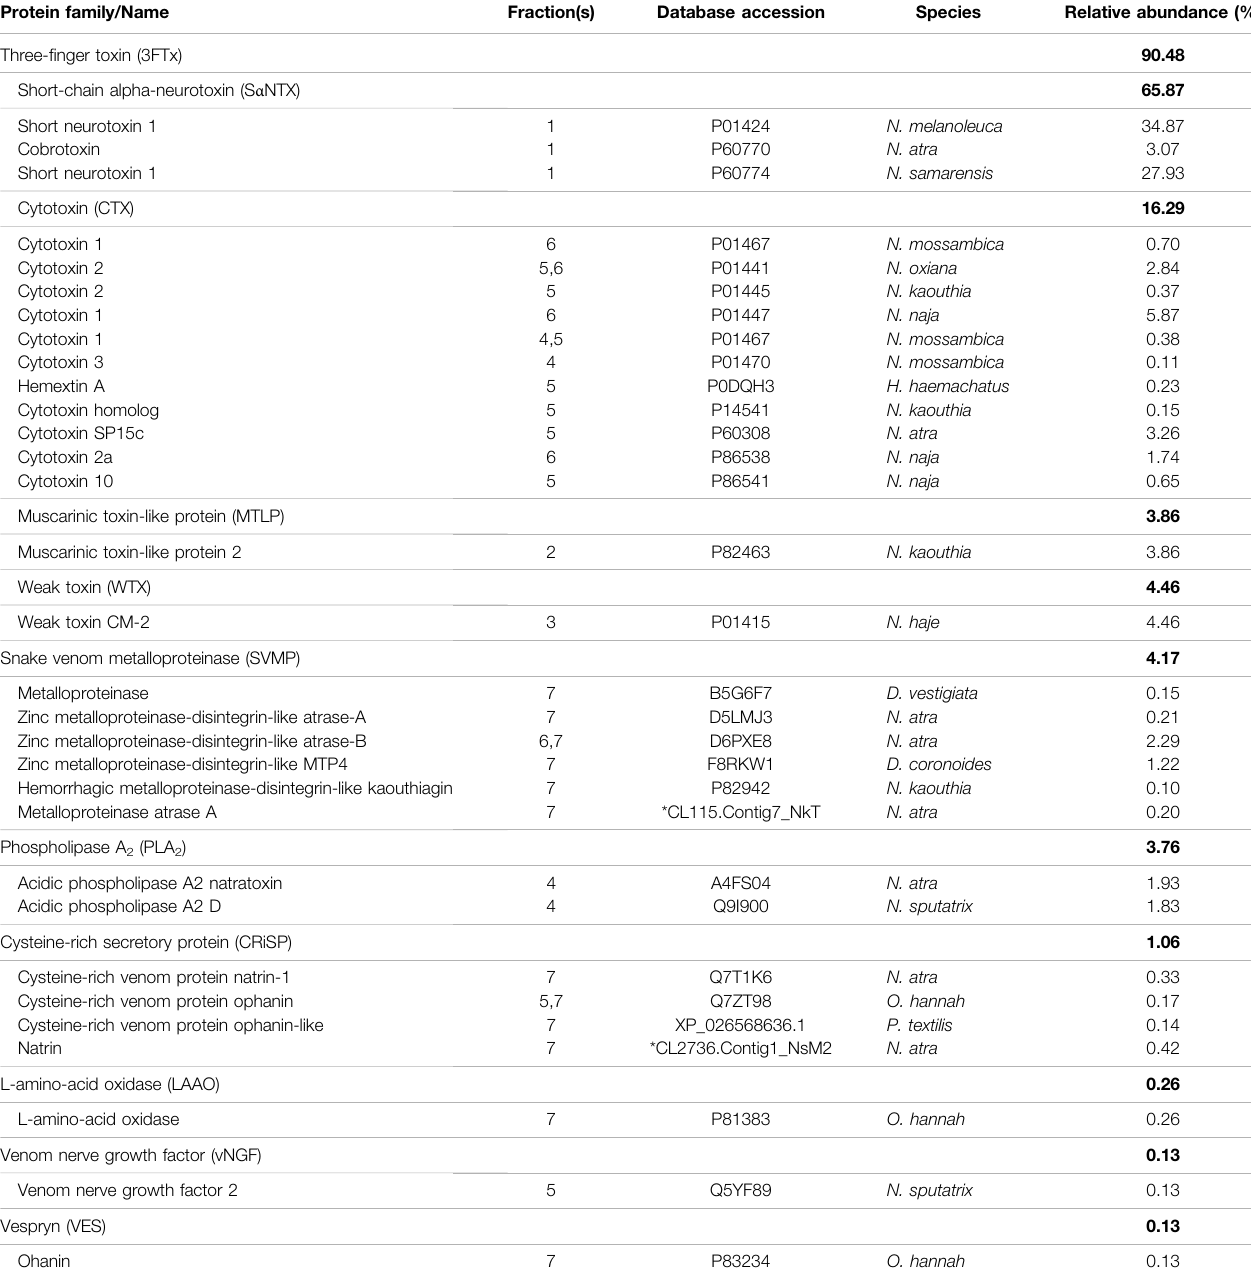
TABLE 2 | Relative abundance of different toxin families identi fi ed from Naja samarensis venom. Protein